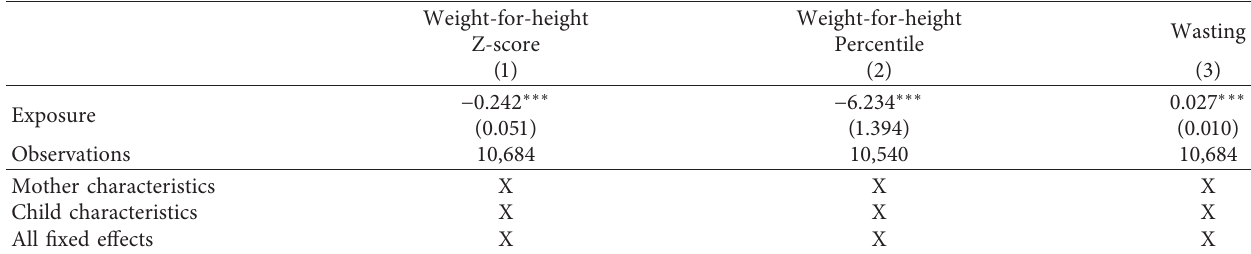
Table 4: Exposure to armed conflict on child weight-for-height: main